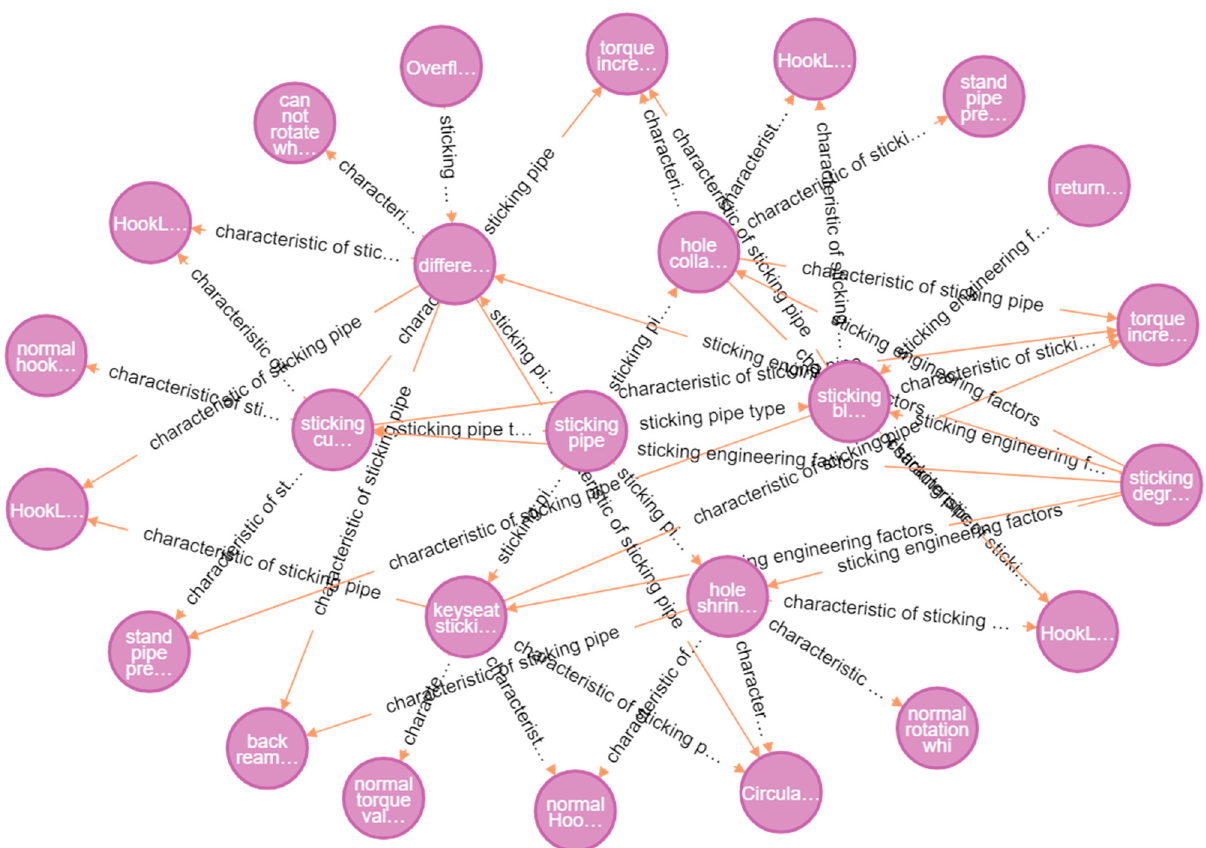
Figure 7. Knowledge graph of stuck pipe types based on digital twins.